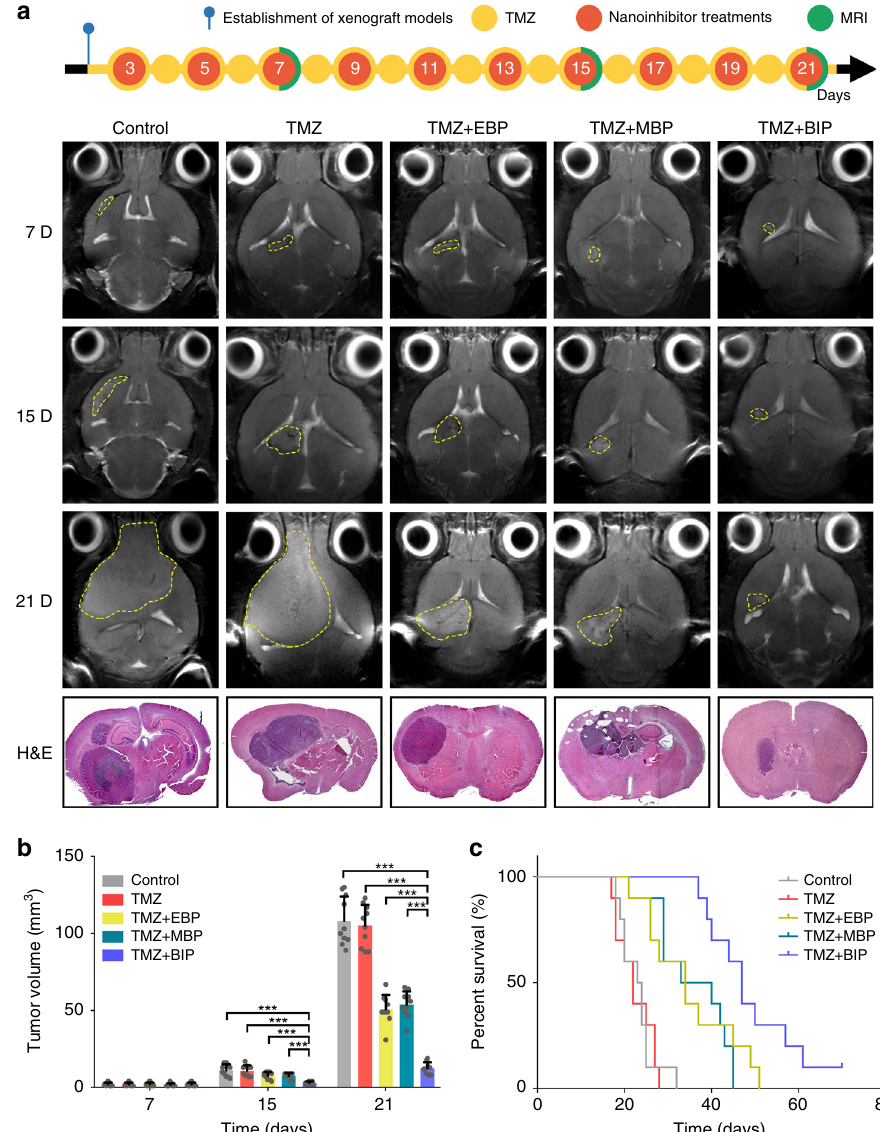
Fig. 6 The therapeutic response of BIP-MPC-NP combined with TMZ in xenografts tumor derived from TMZ-resistant glioma cells. a The diagram showed the process of the establishment of models, drug administration and MRI scan. T2-weighted MR images of mouse head at selected times post treatment with TMZ and different nanoinhibitors. The tumor sizes were visualized by H&E staining image. b Tumor volumes were measured on selected days post tumor implantation ( n = 10). c Kaplan – Meier survival curves of mouse models after corresponding treatments ( n = 10). P = 4.33E − 10 for the four groups. Control vs TMZ, P = 9.04E − 01; Control vs TMZ + EBP, P = 4.22E − 04; Control vs TMZ + MBP, P = 3.40E − 04; Control vs TMZ + BIP, P = 4.00E − 06; TMZ vs TMZ + EBP, P = 4.13E − 02; TMZ vs TMZ + MBP, P = 6.20E − 05; TMZ vs TMZ + BIP, P = 4.00E − 06; TMZ + EBP vs TMZ + MBP, P = 1.57E − 01; TMZ + EBP vs TMZ + BIP, P = 1.32E − 02; TMZ + MBP vs TMZ + BIP, P = 4.82E − 03. The error bars in b represent the S.D. of ten measurements. P value is determined by Student ’ s t -test or log-rank test. Signi fi cant results are presented as * P < 0.05, ** P < 0.01 or *** P < shown to ef fi ciently reduce the proliferation and invasion of tissue 55 . Peptides have the advantage of more easily diffusing into human glioblastoma cells by blocking MET signaling with tissue and having low immunogenicity, yet they are prone to remarkably attenuated levels of phosphorylated MET and its degradation and rapid clearance. Thus, peptides are often used in downstream signaling proteins, such as pAKT and pERK1/2 28 . a stabilized form or as a modular targeting domain in a larger However, with the presence of BBB, glioma patients hardly context 23 . Several approaches have been used to identify targeted peptides 23 . Inherbin3, an antagonist of epidermal growth factor bene fi t from immunological therapy 30 . Generally, the BBB (EGF)-EGFR signaling, inhibits EGF-induced EGFR phosphor- formed by tightly packed cells lining the walls of vessels prevents ylation, cell growth and migration in human tumor cell lines and harmful toxins and bacteria in the blood stream from entering the suppresses tumor growth in a tumor xenograft model 25 . cMBP vital organ. What evolved as a life-saving defense, however, also peptide targets ligand due to its high binding af fi nity to MET and blocks many molecules from reaching the brain, creating a major application in tumor imaging 36 . Nanoinhibitors containing cMBP problem in treating brain tumors 29 . Based on the molecular peptides conjugated on the G4 PEGylated dendrimer have been structure of phosphatidycholine of cell membranes, a synthetic